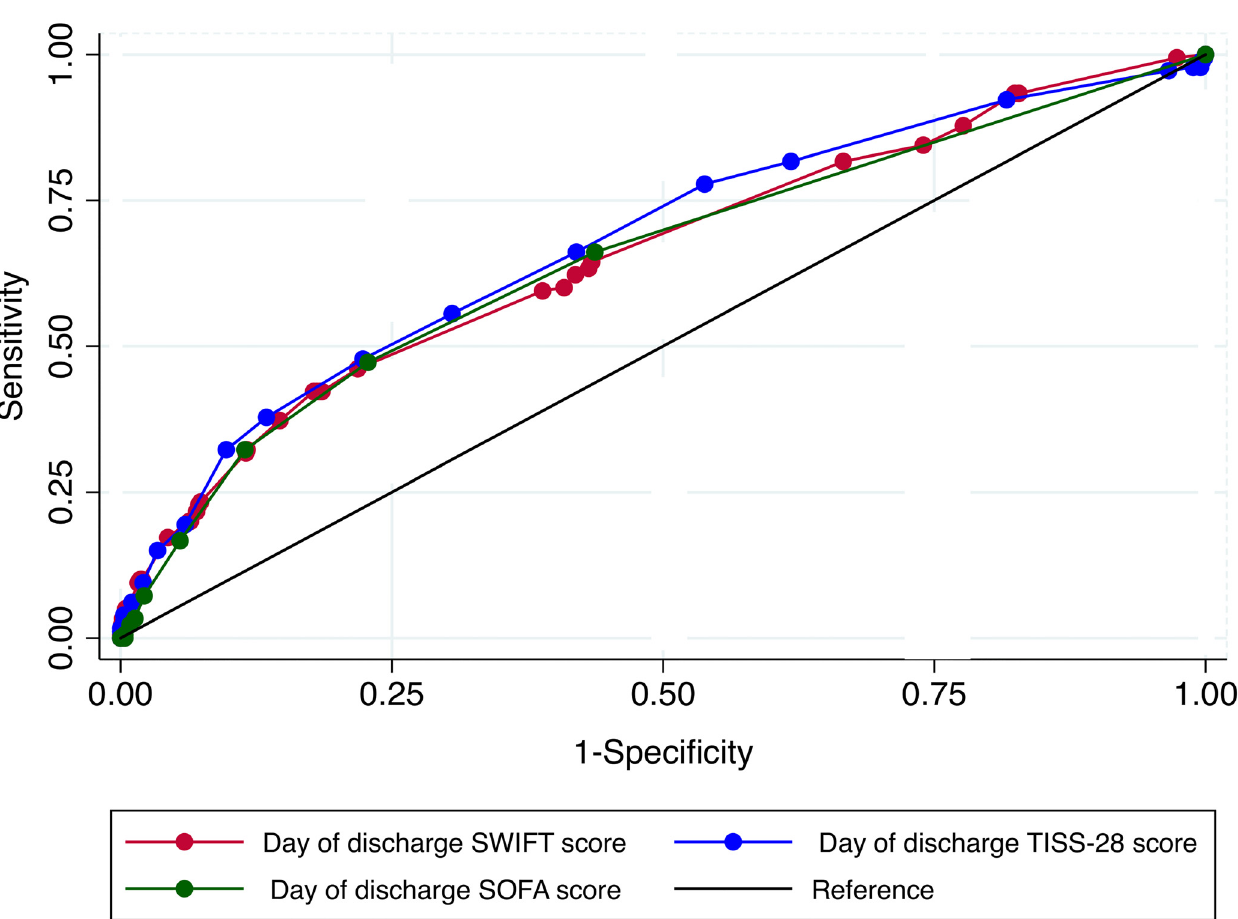
Fig 1. Comparison of receiver operating characteristic (ROC) curves for unplanned intensive care unit readmission or death among SWIFT, SOFA and TISS-28 scores.